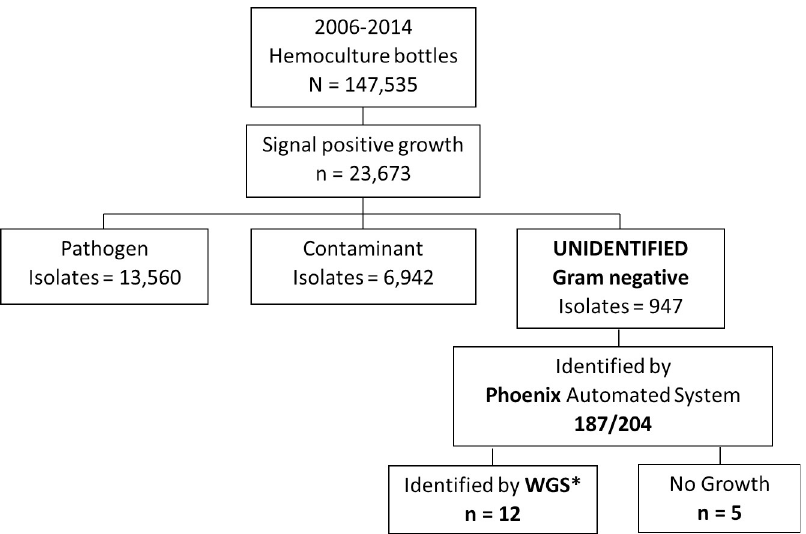
Fig 1. Flow diagram denoting blood culture results from blood-stream infection surveillance in two rural Thai provinces from 2006–2014. � WGS–whole genome sequencing.